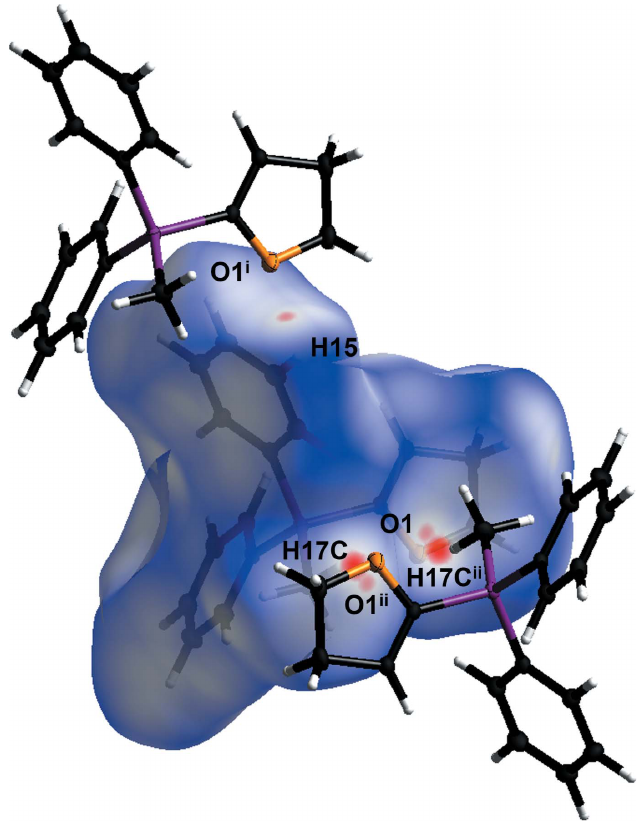
Figure 8 Hirshfeld surface analysis of 2 showing close contacts in the crystal. The weak hydrogen bond between oxygen atom O1 and the H15 hydrogen atom, as well as the weak hydrogen bonds between the oxygen atom O1 and the H17 C hydrogen atom are labeled. [Symmetry codes: (i) x , y + 1, z ; (ii) (cid:3) x + 2, (cid:3) y + 1, (cid:3) z + 1].